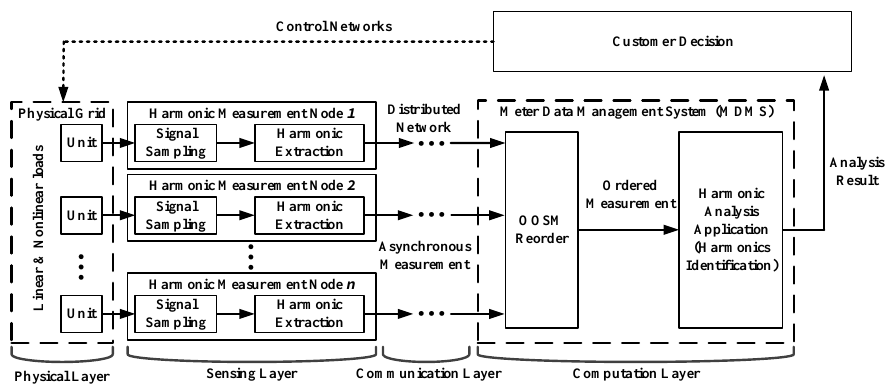
Figure 2. Distributed measuring schedule for harmonic analysis in the cyber-physical energy system, including sensing, communication, computation and control. The out-of-sequence measurement (OOSM) occurs in the asynchronous communication network and is rectified before the analysis process. However, as the network scale grows, the complexity of sensing network communication